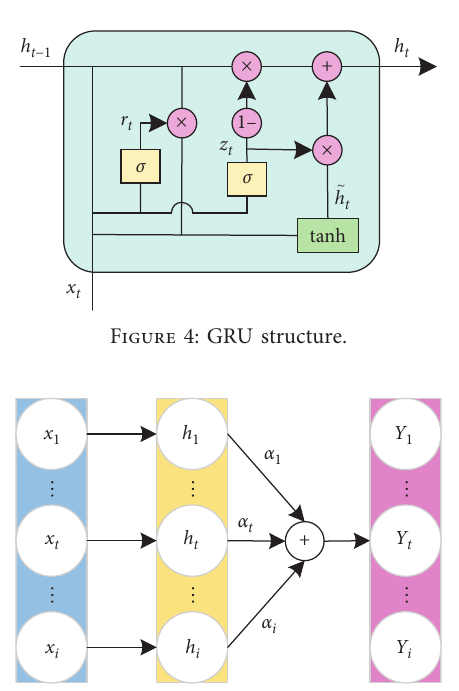
Figure 5: Attention mechanism structure.